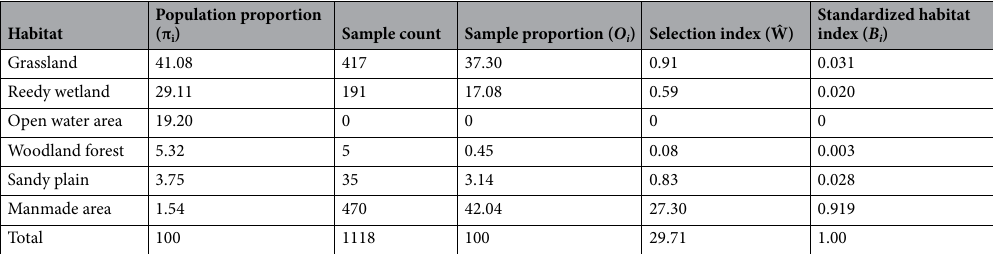
Table 1. Calculation of standardized habitat index ( B i ) as a proportion of selection index (Ŵ) based on radio tracking for E. dione . Population proportion (π i ) is calculated as a percentage of the total area, for each of the habitats covered. Sample counts are the number of fixes in each habitat. Sample proportion ( O i ) is the sample count as a percentage; selection index is calculated by Ŵ = O i /π i .